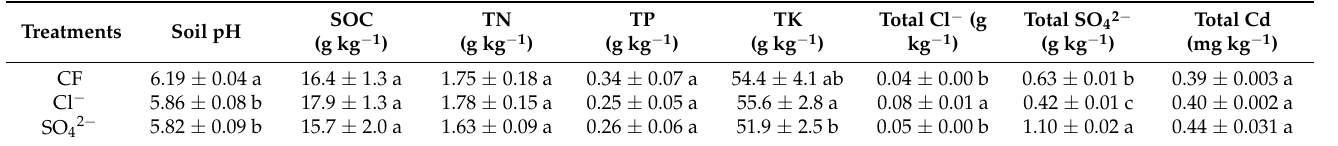
Table 2. Physicochemical properties of the soil following long-term applications of Cl − - and SO 42 − - based